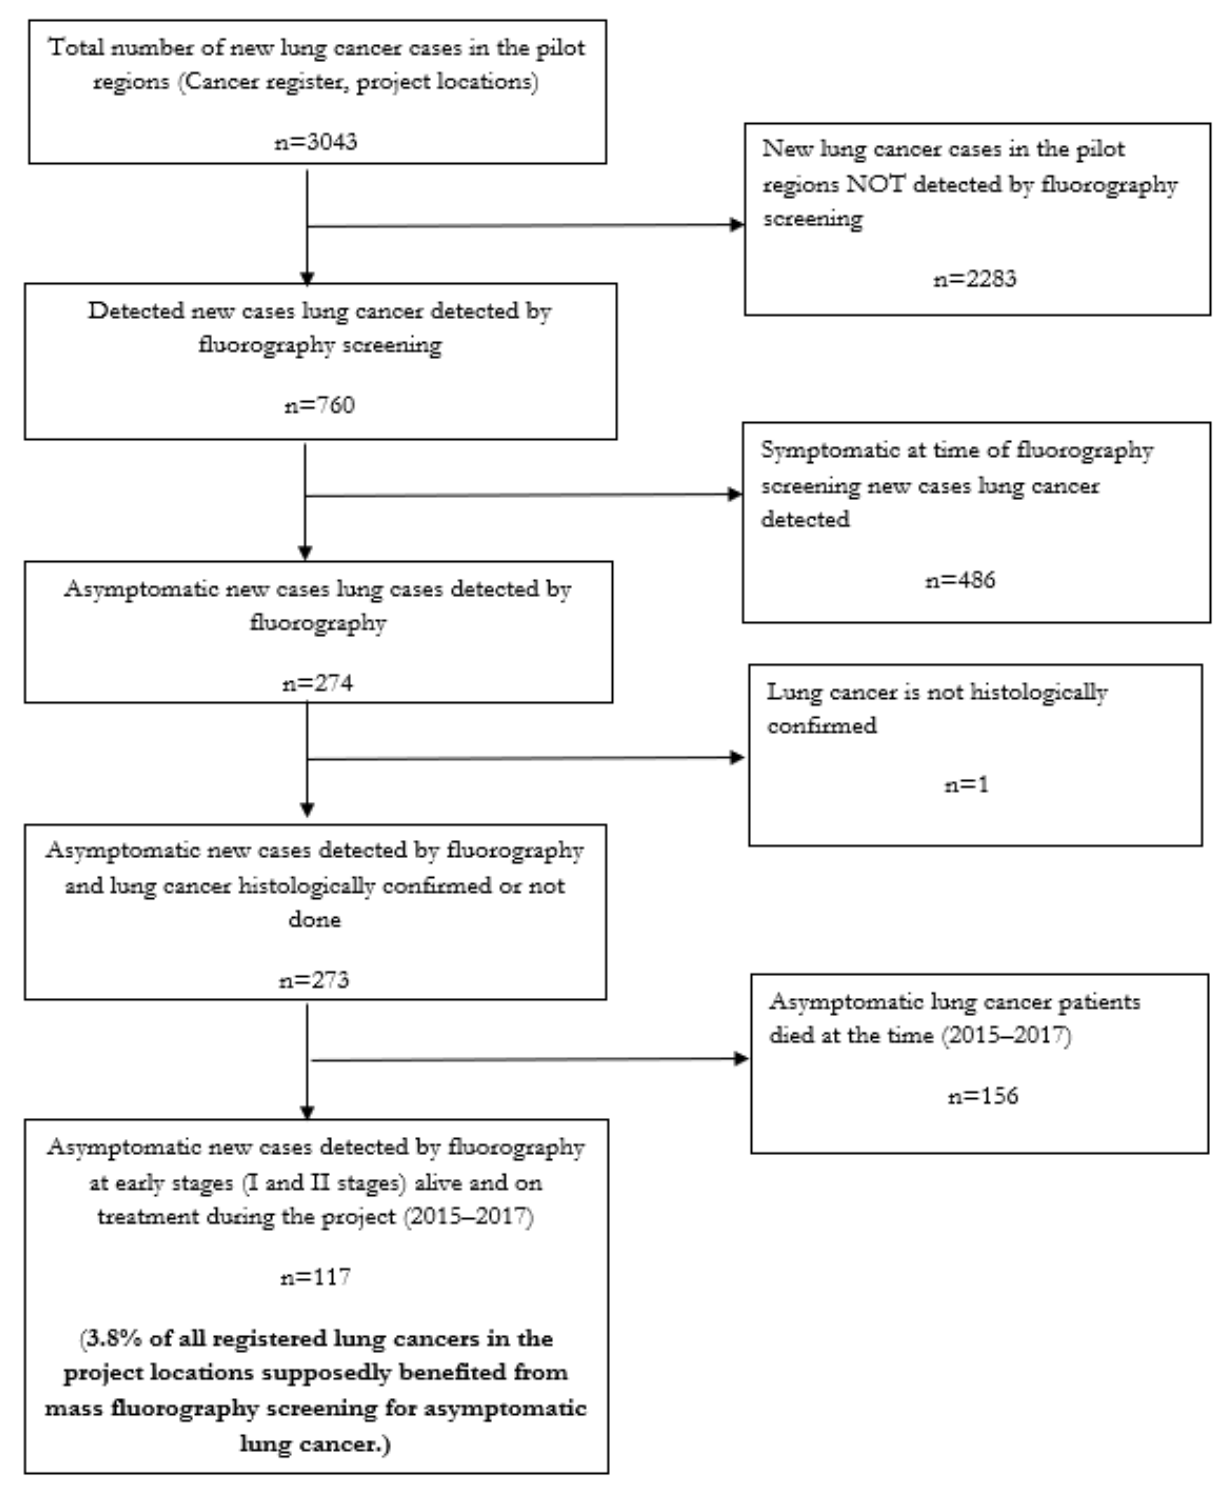
Figure 3. The proportion of asymptomatic cases of lung cancer that was detected at early stages (I and II stages) by fluorography preventive mass screening out of all the registered lung cancer cases in the FLUTE study locations of Minsk city, Homiel city, Homiel district, and Rechitsa district (Belarus) 2015–2017.